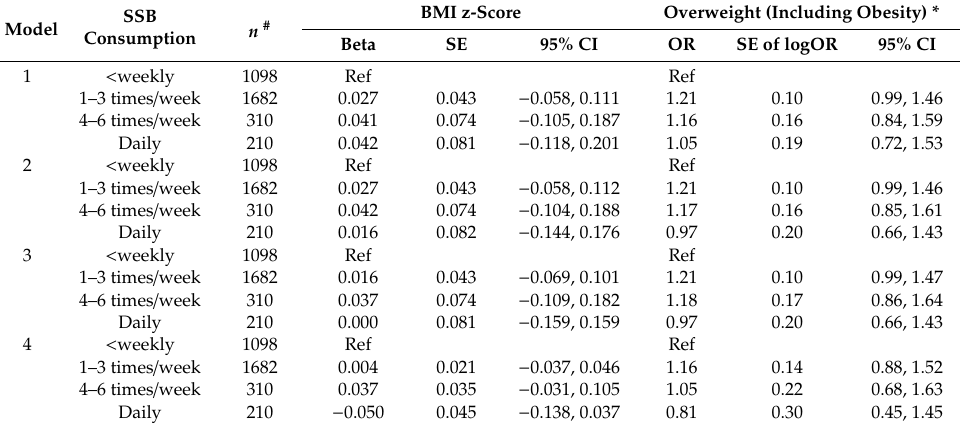
Table 2. Associations of sugar-sweetened beverage (SSB) consumption at 11 years with body